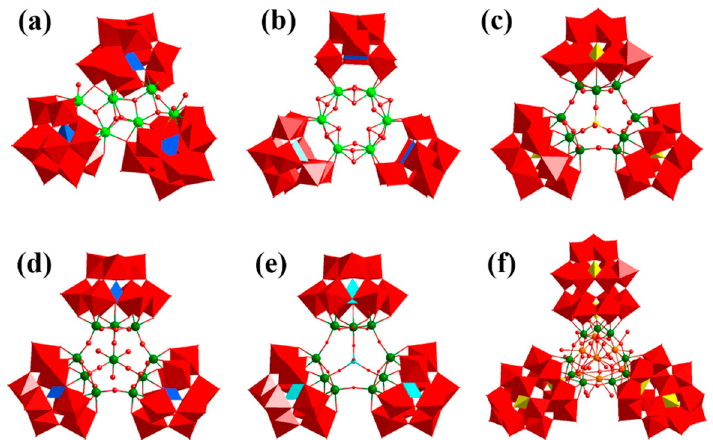
Figure 5. The ball ‐ and ‐ stick and polyhedral illustration of ( a ) Zr 6 O 2 (OH) 4 (H 2 O) 3 ( β ‐ SiW 10 O 37 ) 3 ] 14 − polyoxoanion, ( b ) [Zr 6 (O 2 ) 6 (OH) 6 ( γ ‐ SiW 10 O 36 ) 3 ] 18 − polyoxoanion, ( c ) [( α ‐ Ti 3 PW 9 O 38 ) 3 (PO 4 )] 18 − polyoxoanion, ( d ) [( α ‐ Ti 3 SiW 9 O 37 OH) 3 (TiO 3 (OH 2 ) 3 )] 17 − polyoxoanion, ( e ) {K ⸦ [(Ge(OH)O 3 )(GeW 9 Ti 3 O 38 H 2 ) 3 ]} 14 − polyoxoanion and ( f ) [{Ca 6 (CO 3 )( μ 3 ‐ OH)(OH 2 ) 18 }(P 2 W 15 Ti 3 O 61 ) 3 Ca(OH 2 ) 3 ] 19 − polyoxoanion. Color codes: WO 6 , red; PO 4 , yellow; SiO 4 , light blue; GeO 4 , turquoise; Ti, green; Zr, bright green; Ca, orange; C, gray; O, red.